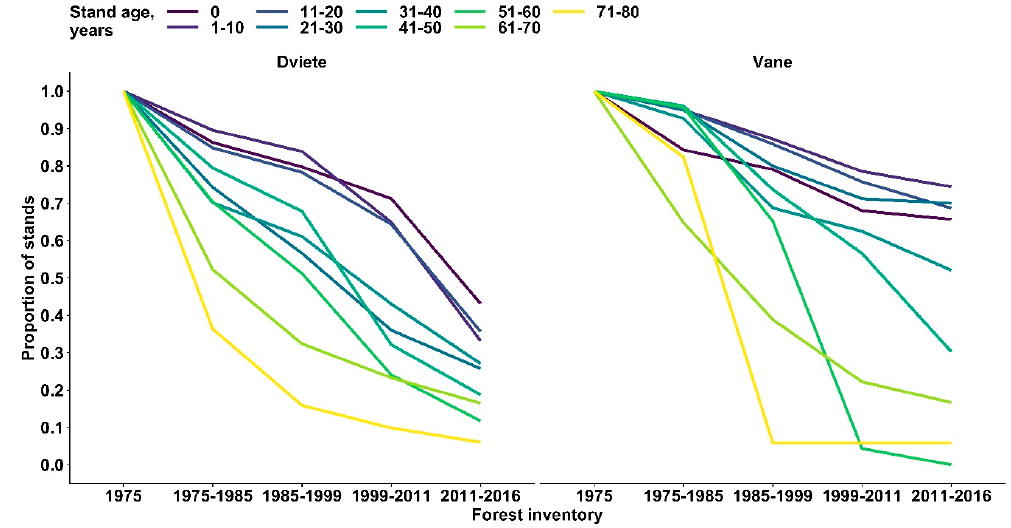
Figure 7. The proportion of successfully transitioned Norway spruce stands in both landscapes between observation periods by stand age group in 1975: In each forest inventory, the remaining part from the initial number of Norway spruce stands in a particular age group is shown.